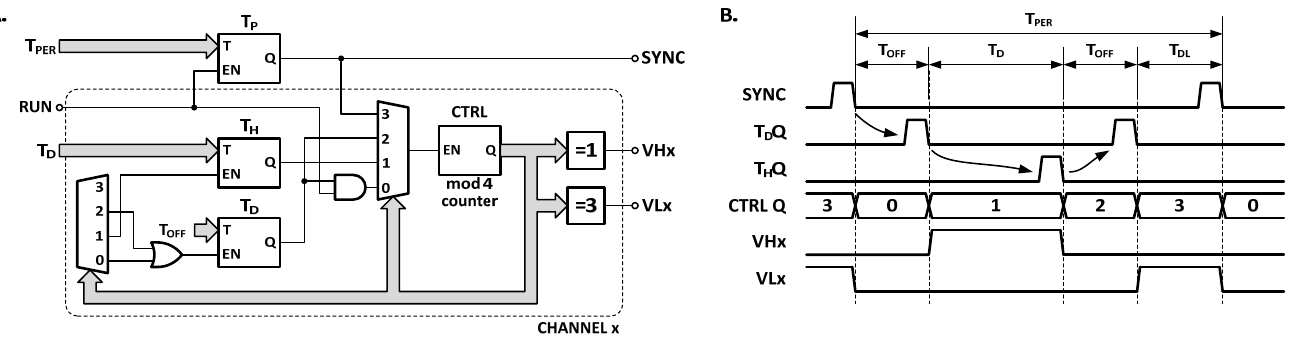
Figure 4. The PWM controller block diagram ( A ) and simplified operation waveform ( B ).